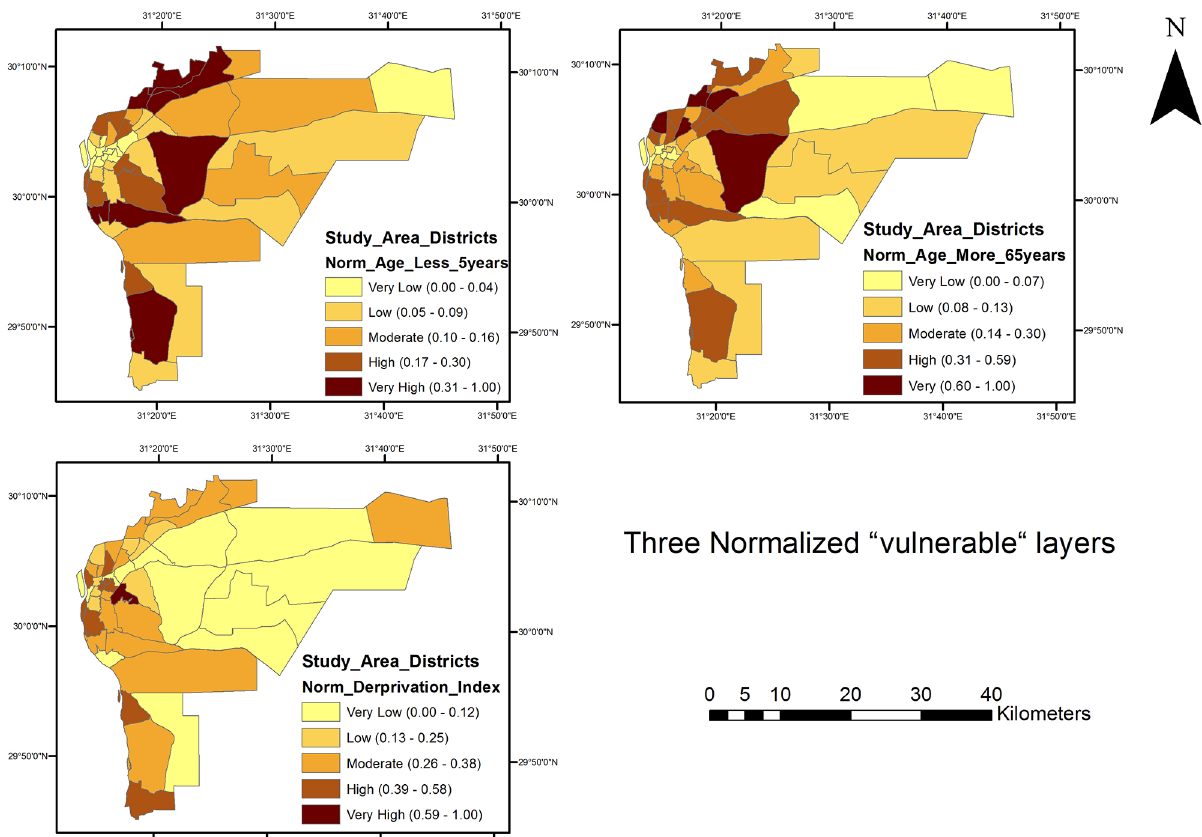
Fig. 8. Normalised vulnerability layers of Cairo Governorate districts. Source: